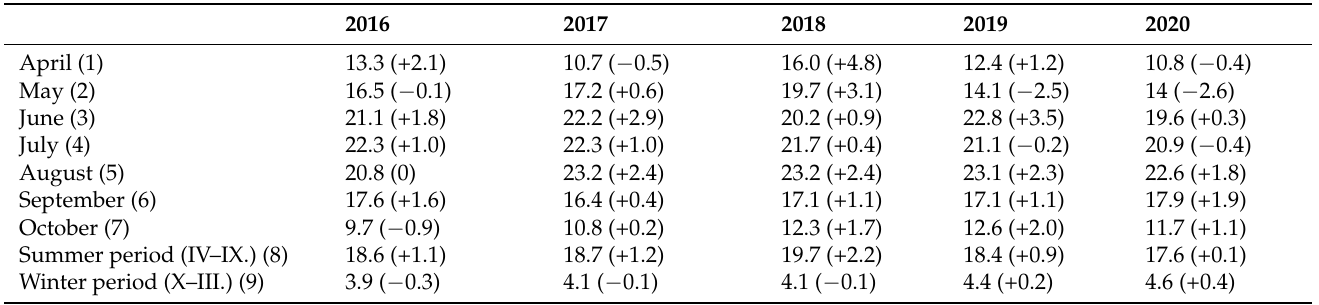
Table 3. Mean monthly air temperature ( ◦ C) in the growing season of maize at Debrecen-L á t ó k é p